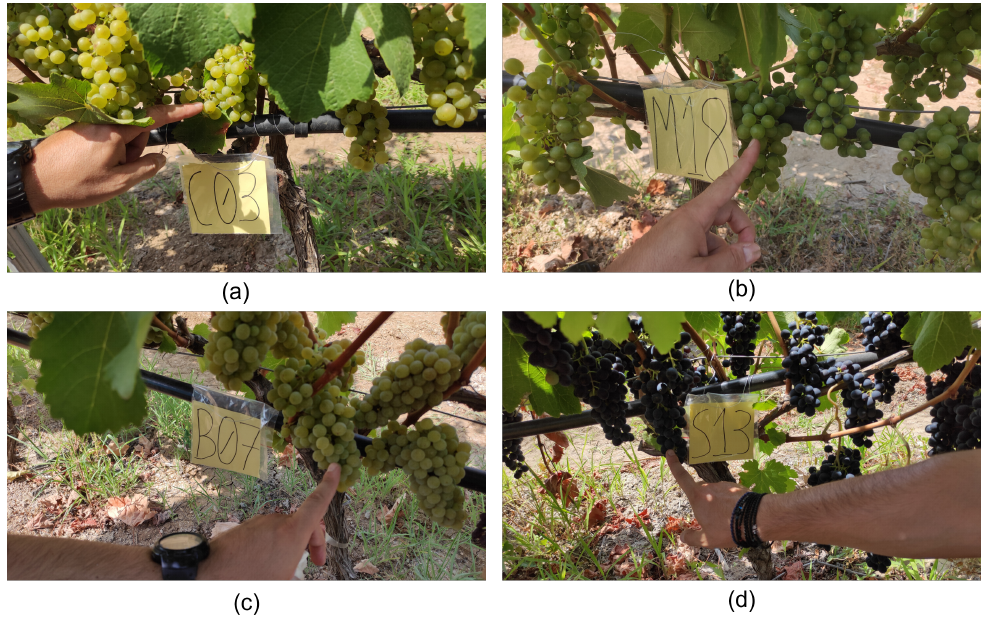
Figure 3. Labeled bunches in the four different examined varieties ( a ) Chardonnay, ( b ) Malagouzia, ( c ) Sauvignon-Blanc, and ( d )